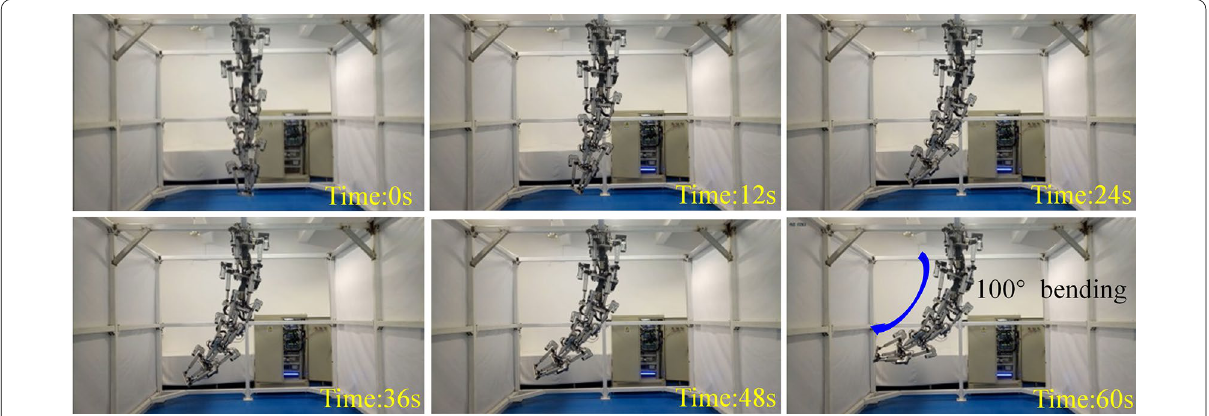
Figure 24 100° bending configuration of